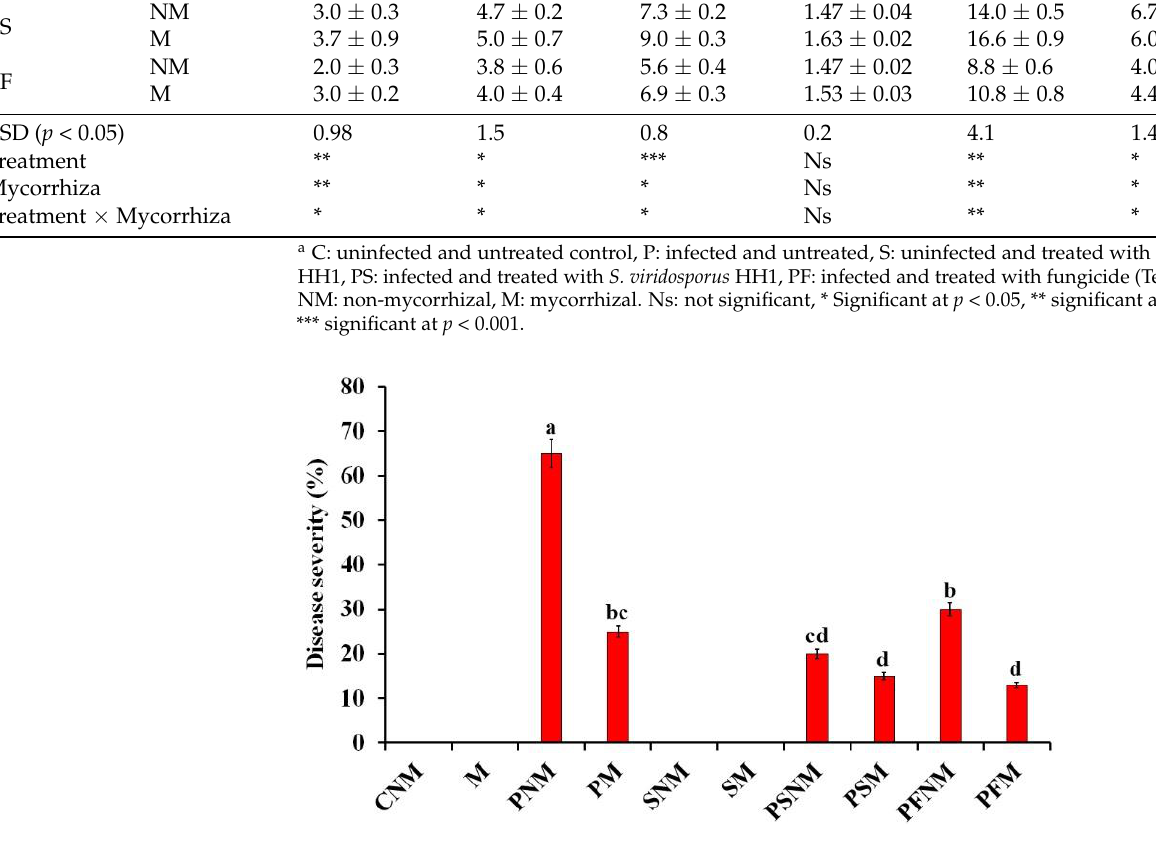
Figure 3. Histogram showing the disease severity of Fusarium wilt in pea plants in response to treatment with S. viridosporus HH1 and/or colonization with R. irregularis at 40 days post planting. Where CNM: uninfected, untreated, and non-mycorrhizal, M: uninfected, untreated, and mycorrhizal, PNM: infected, untreated, and non-mycorrhizal, PM: infected, untreated, and mycorrhizal, SNM: uninfected, treated with S. viridosporus HH1, and non-mycorrhizal, SM: uninfected, treated with S. viridosporus HH1, and mycorrhizal, PFNM: infected, treated with chemical fungicide, and non-mycorrhizal, PFM: infected, treated with chemical fungicide, and mycorrhizal, PSNM: infected, treated with S. viridosporus HH1, and non-mycorrhizal, PSM: infected, treated with S. viridosporus HH1, and mycorrhizal. Columns superscripted with the same letter(s) are not significantly different according to Tukey ’ s HSD test at p ≤ 0.05. Values represent the m ean of five samples per treatment. Error bars represent standard errors.